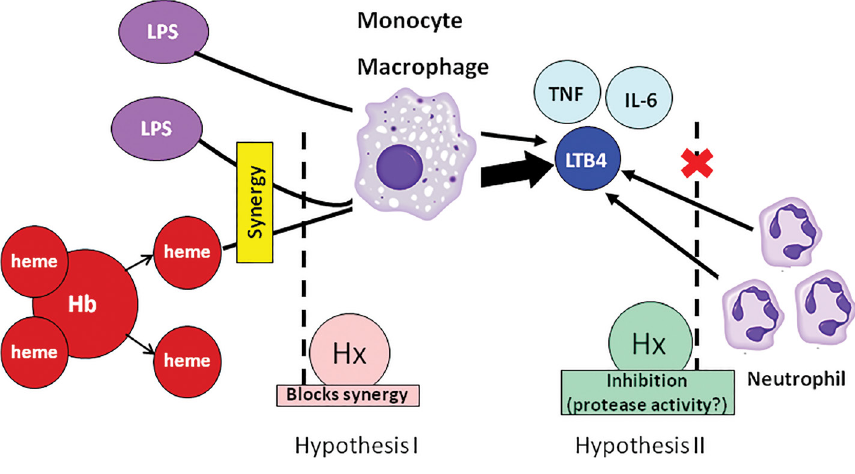
Figure 8. The role of Hx in neutrophil chemotaxis. The pathogenesis of severe infectious diseases is associated with hemolysis and secondary release of cell-free heme. LPS and heme synergize to induce the production of TNF, IL-6 and LTB4 from monocytes/ macrophages. LTB4 induces neutrophil migration. Two hypotheses might explain the effect of Hx to suppress chemotaxis of neutrophils: hypothesis I, Hx binds heme and there- fore blocks synergistic production of LTB4 and other chemotaxins, secondarily decreasing the signal for the chemotaxis of neutrophils; hypothesis II, Hx itself has protease activity and direct inhibitory effect on the neutrophil migration. The results from this paper support hypothesis